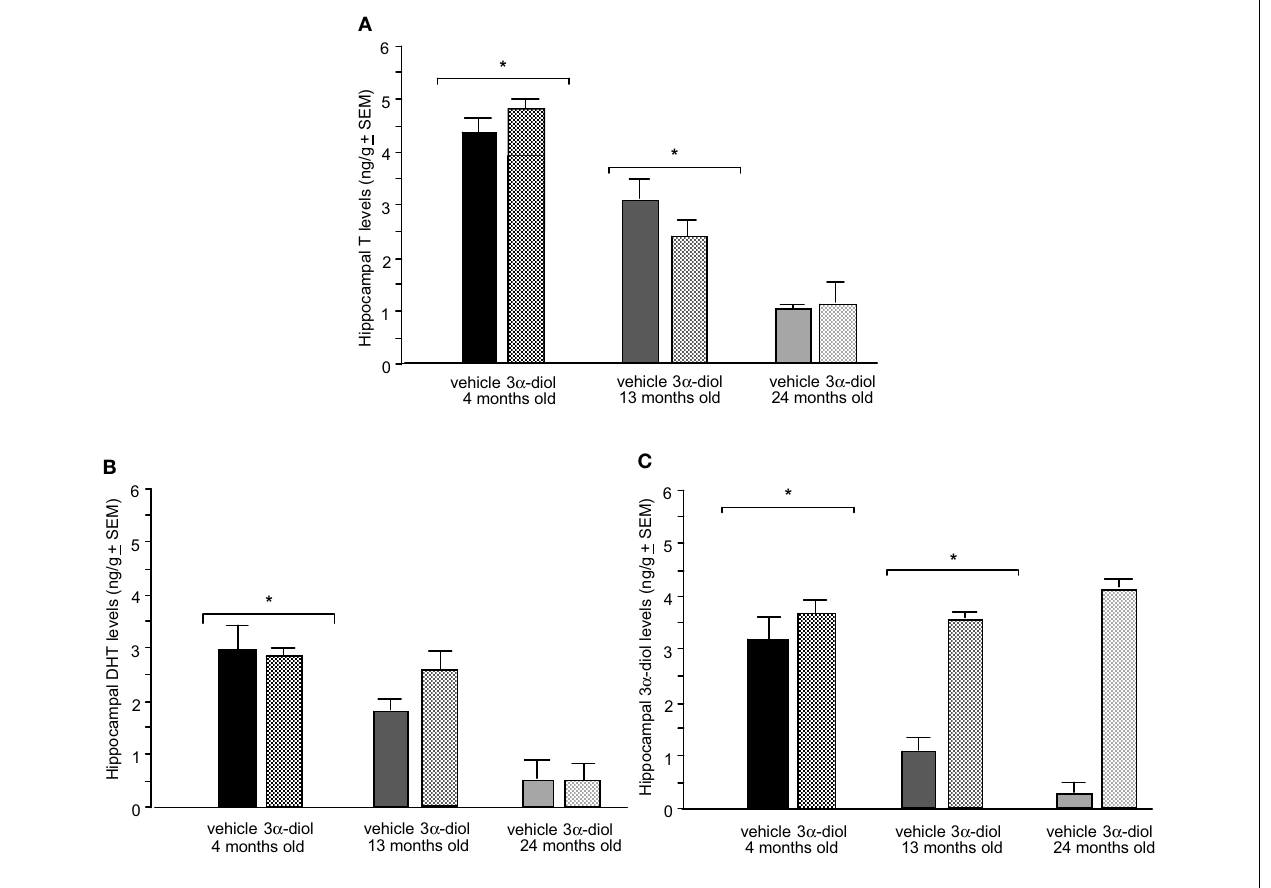
FIGURE 6 | Represents hippocampal levels of T (A), DHT (B), and 3 α -diol (C) of 4- (black bars), 13- (dark grey bars), and 24- (light grey bars) month-old gonadally-intact rats administered subcutaneous injections of sesame oil vehicle (solid bars) or 3 α -diol (checkered bars). *Denotes